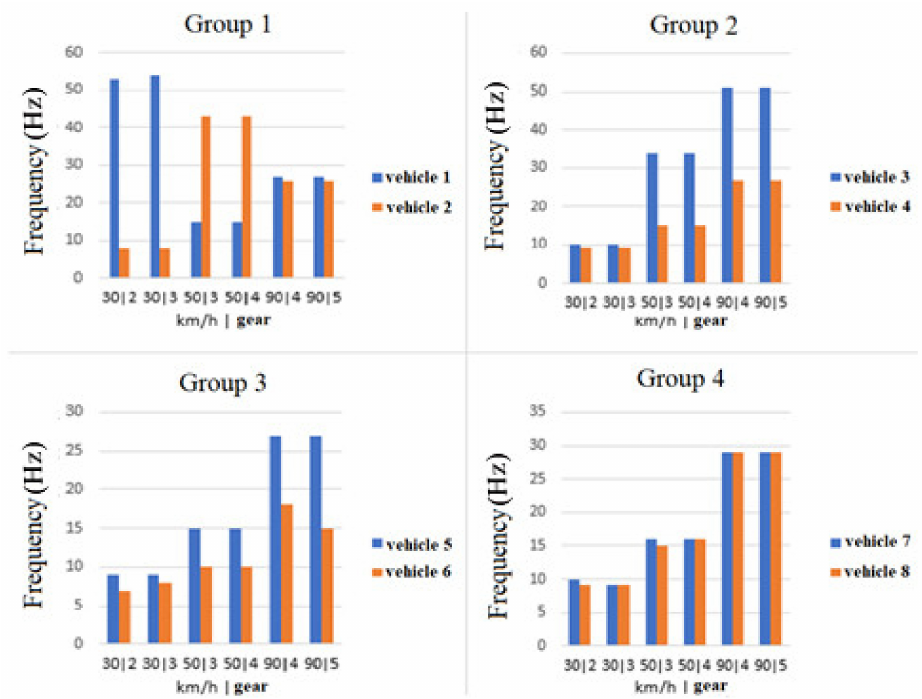
Figure 8. Comparison of dominant harmonic vibration values measured at the headrest mounting (the seat), in each; for the older (blue) and the newer models (orange).